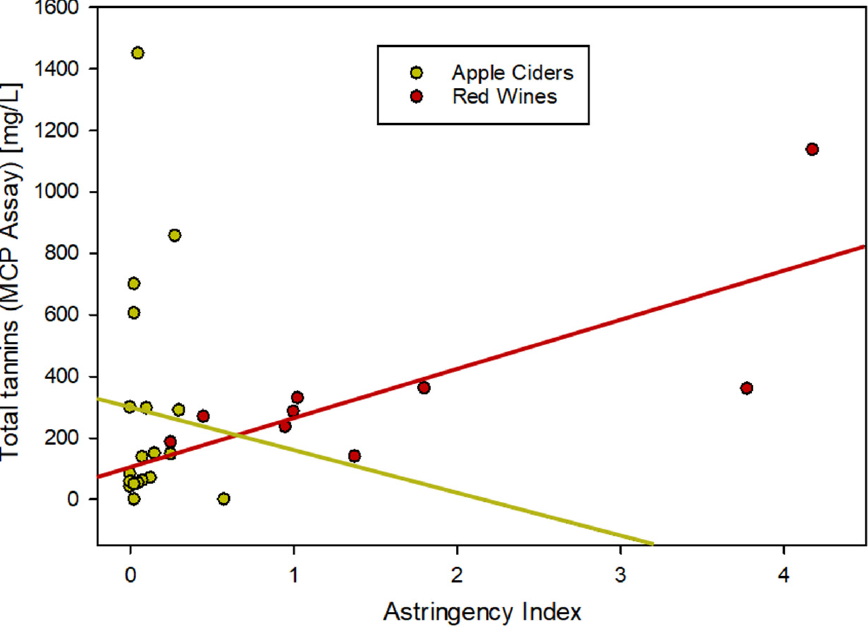
Figure 3. Correlation between tannin material and astringency in apple cider compared to red wine.